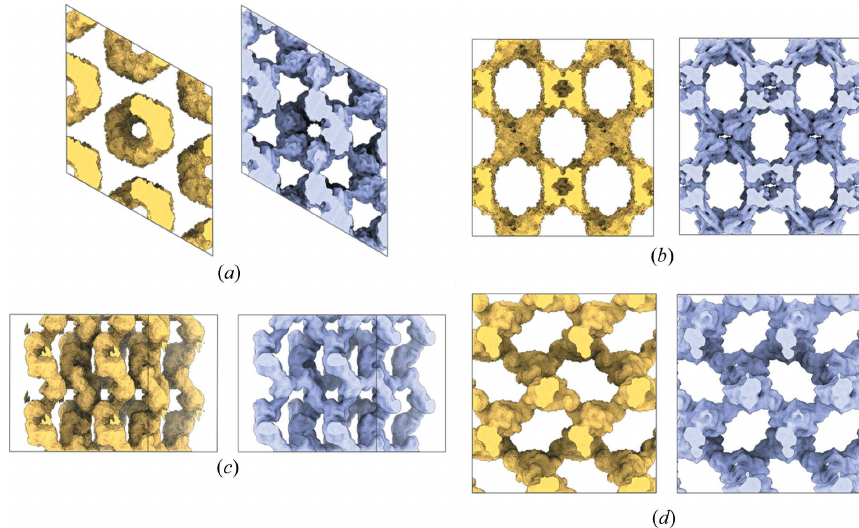
Figure 4 Comparison of consensus molecular envelopes with model envelopes. ( a ) Test case 5b2c (Kubota et al. , 2016) (solvent fraction 0.73, space group P6 1 ), CC = 0.67, simple match between envelopes 87%. ( b ) Test case 5hk7 (Arrigoni et al. , 2016) (solvent fraction 0.83, space group I 222), CC = 0.60, simple match between envelopes 90%. ( c ) Test case 4bex (Klejnot et al. , 2013) (solvent fraction 0.73, space group P 3 2 21), CC = 0.77, simple match between envelopes 92%. ( d ) Test case 2rha (Joint Center for Structural Genomics, unpublished work) (solvent fraction 0.80, space group P 4 3 2 1 2), CC = 0.86, simple match between envelopes 95%. Displayed in surface representation is the volume associated with 4 adjacent unit cells, from a single viewpoint. The consensus envelopes generated by the clustering and averaging procedure are shown in gold, and the model envelopes are shown in light blue. Figs. 4, 5 and 6 were prepared with the aid of UCSF ChimeraX (Pettersen et al. ,